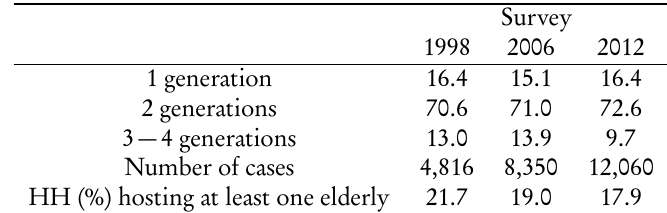
Distribution (%) of the households by the number of generations. Egypt 1998, 2006 and 2012. Note: Weighted